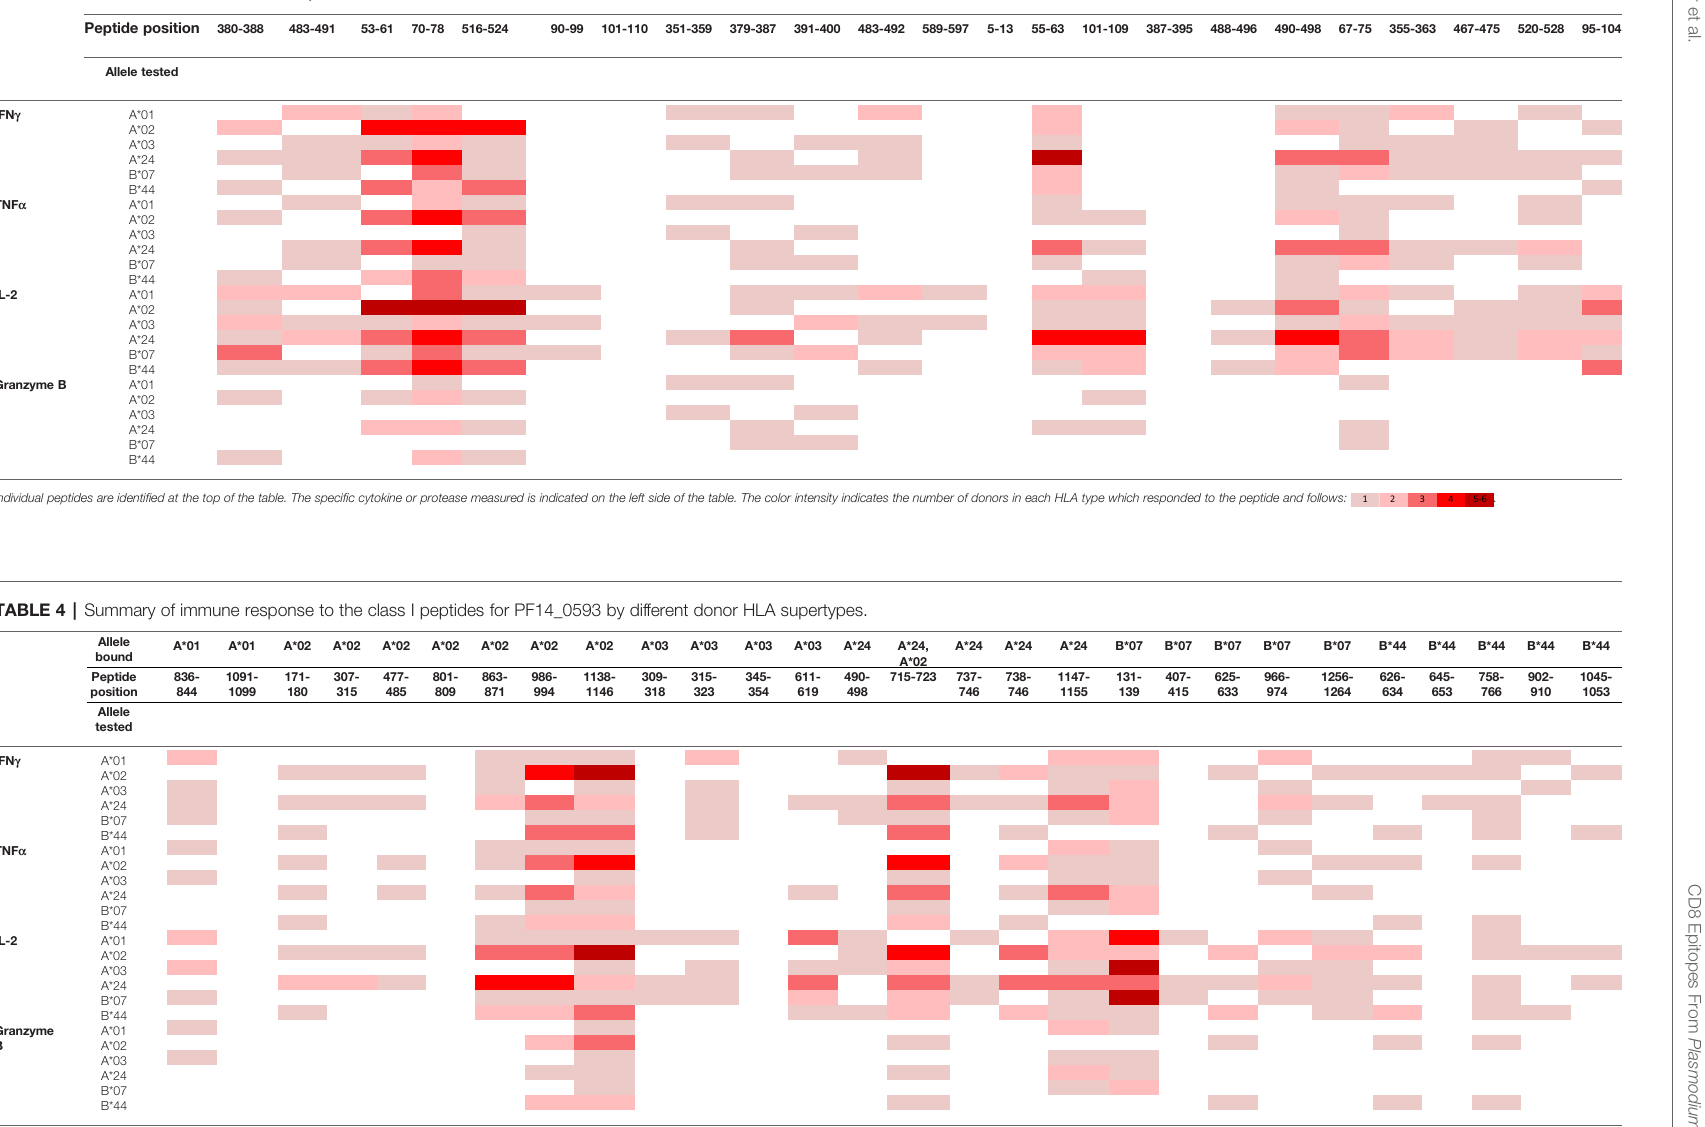
T u c k e r e t a l